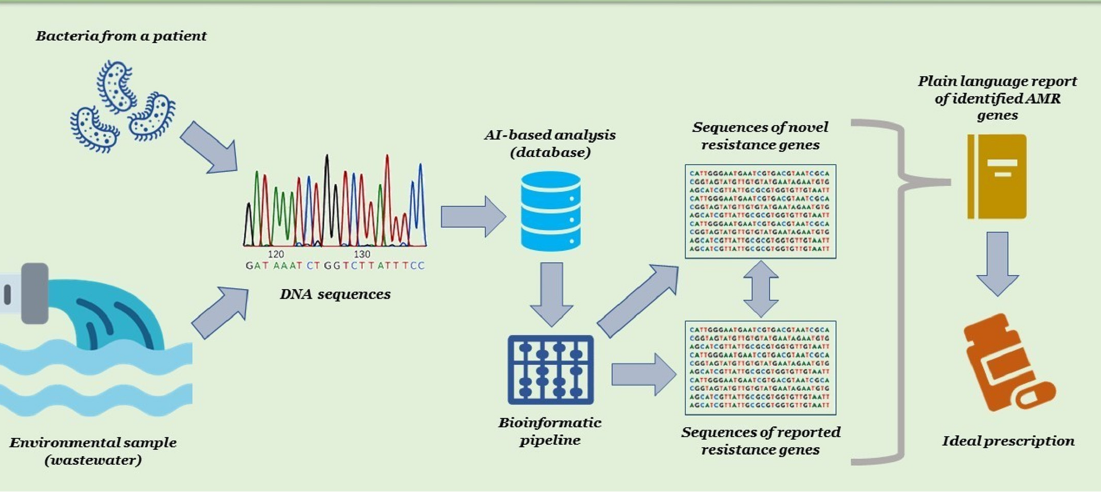
Figure 3. Deep antibiotic-resistant gene-sequencing model.